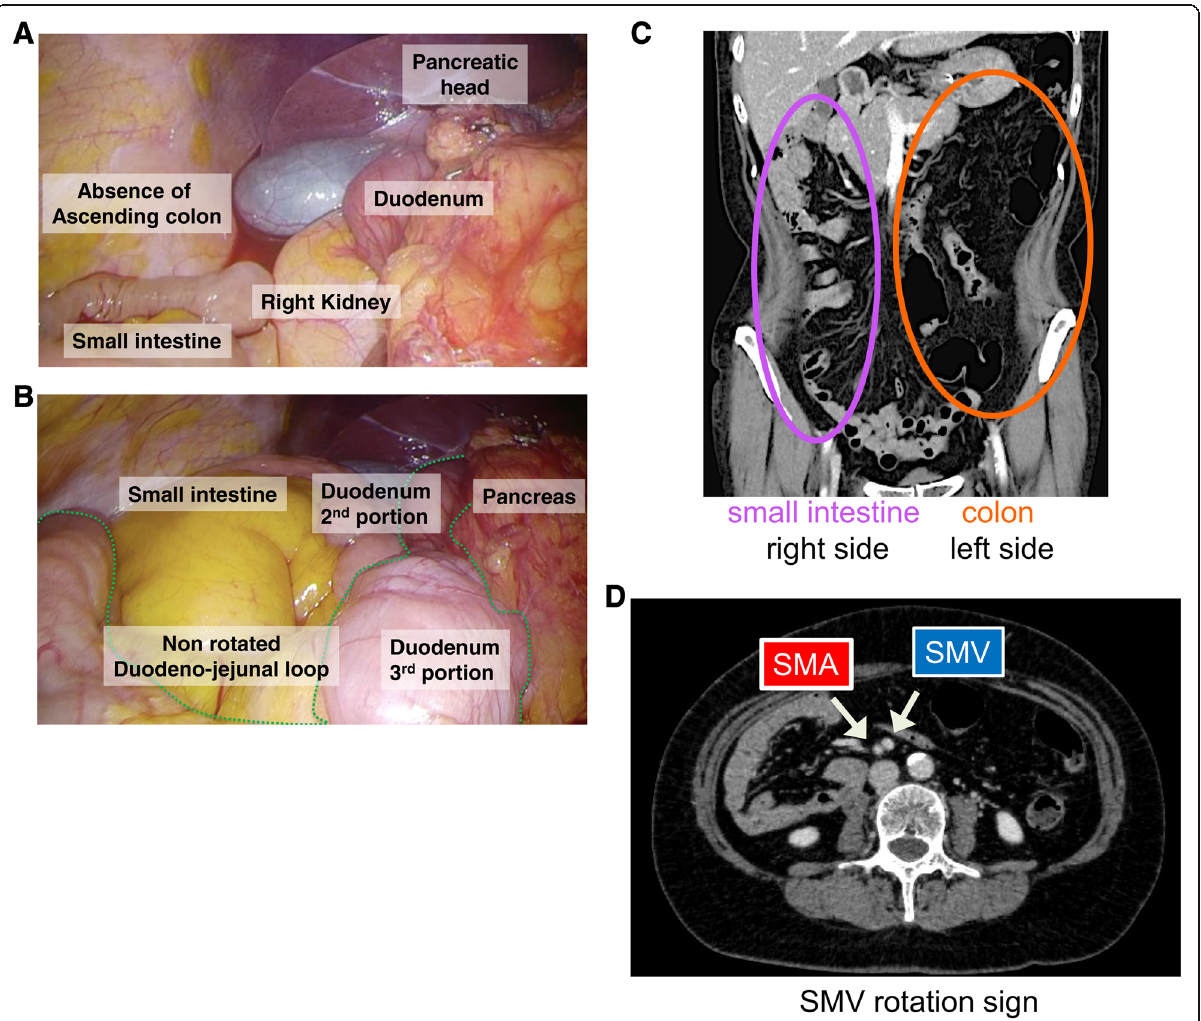
Fig. 3 Operative views before reconstruction and CT findings, indicating asymptomatic intestinal malrotation. a , b There was no right-side colon at the hepatic flexure, and the duodenum did not rotate to the left side of the body. The small intestine was located on the right side of the abdomen, with a completely mobilized duodenum. c A right-sided small bowel and left-sided colon sign were confirmed on reviewing the CT image. d SMV rotation sign: SMV existed abnormally on the left side of the superior mesenteric artery